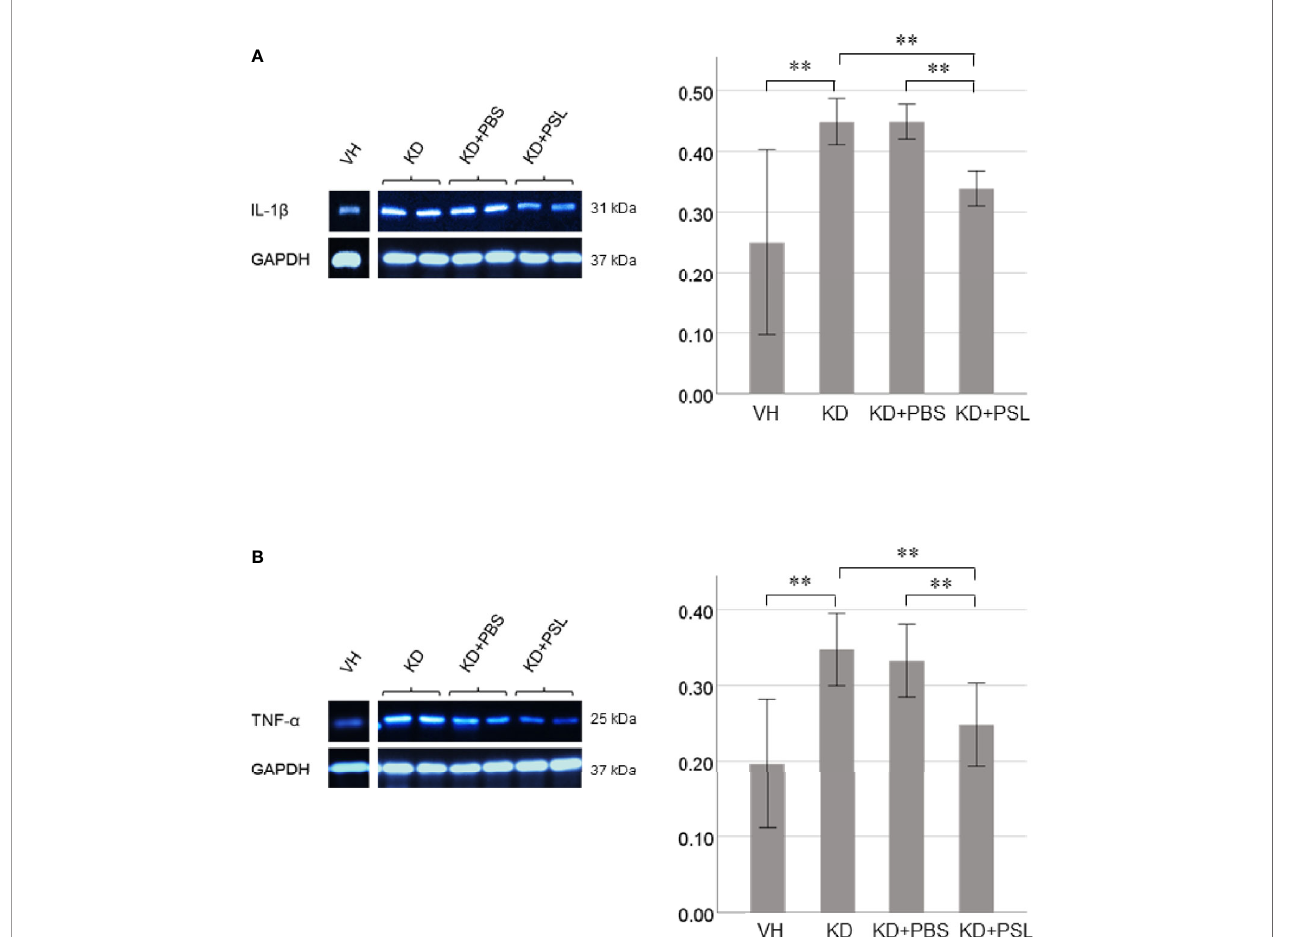
FIGURE 5 | Cytokine production in serum-activated human coronary artery endothelial cell (HCAEC) lysates. Western blot analysis and quantitation of (A) IL-1 b and (B) TNF- a production in serum-activated HCAEC lysates from healthy controls (VH) and Kawasaki disease (KD), and KD serum-activated HCAECs treated with PBS and prednisolone (PSL) (8 independent experiments). GAPDH was used as an internal standard. ** P < 0.01 (one-way ANOVA followed by Bonferroni